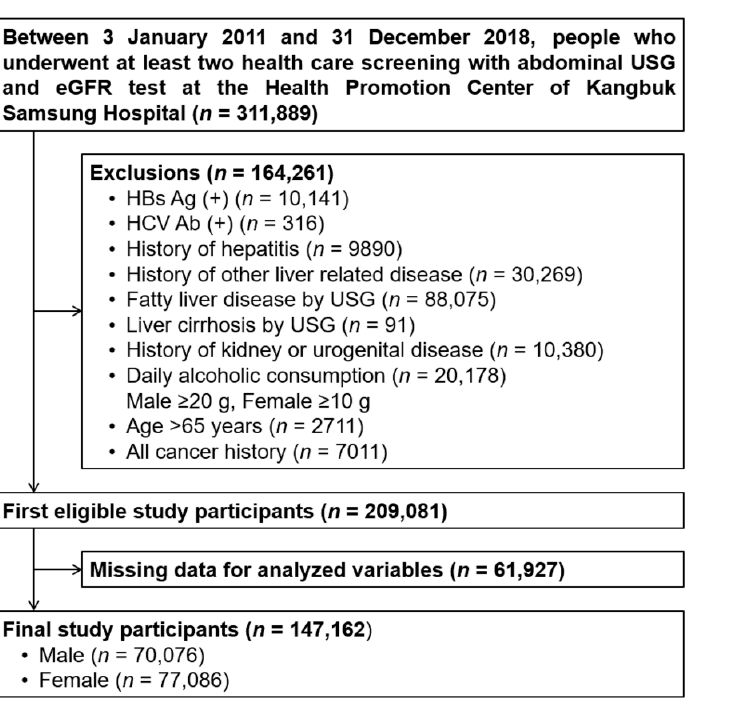
Figure 1. Diagram of study enrollment. eGFR: estimated glomerular filtration rate, HBs Ag: hepatitis B virus surface antigen, HCV Ab: hepatitis C virus antibody, USG: ultrasonography.